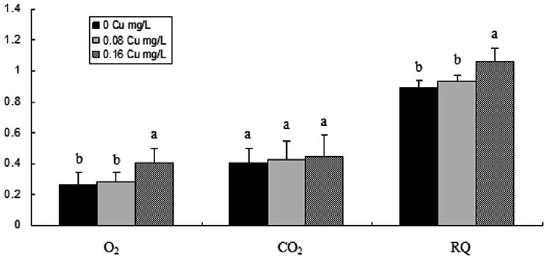
Fig. 4. – Oxygen consumption rates (mg g –1 h –1 ), CO rates (mg g –1 h –1 ) and respiratory quotient (RQ) of megalopa larvae exposed to copper. Values are means ± SE ( n =4). Bars sharing dif- ferent letters in each index are significantly different (P <